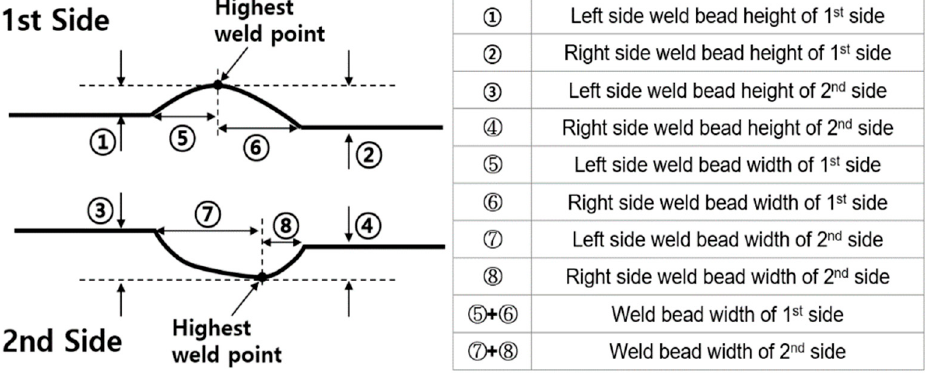
Figure 14. Schematic diagram of the weld bead height and width measurement. Toe Angle